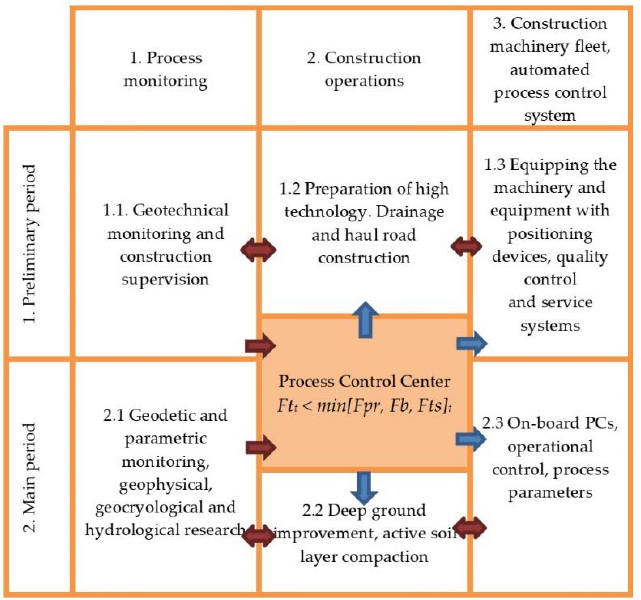
Figure 2. The technological structure of strengthening the subgrade support in the construction period ( Ft t —process load; Fpr —ultimate strength of the soil, Fb —safe load for the weak layer; Fts —thixotropic load limit in period t ).